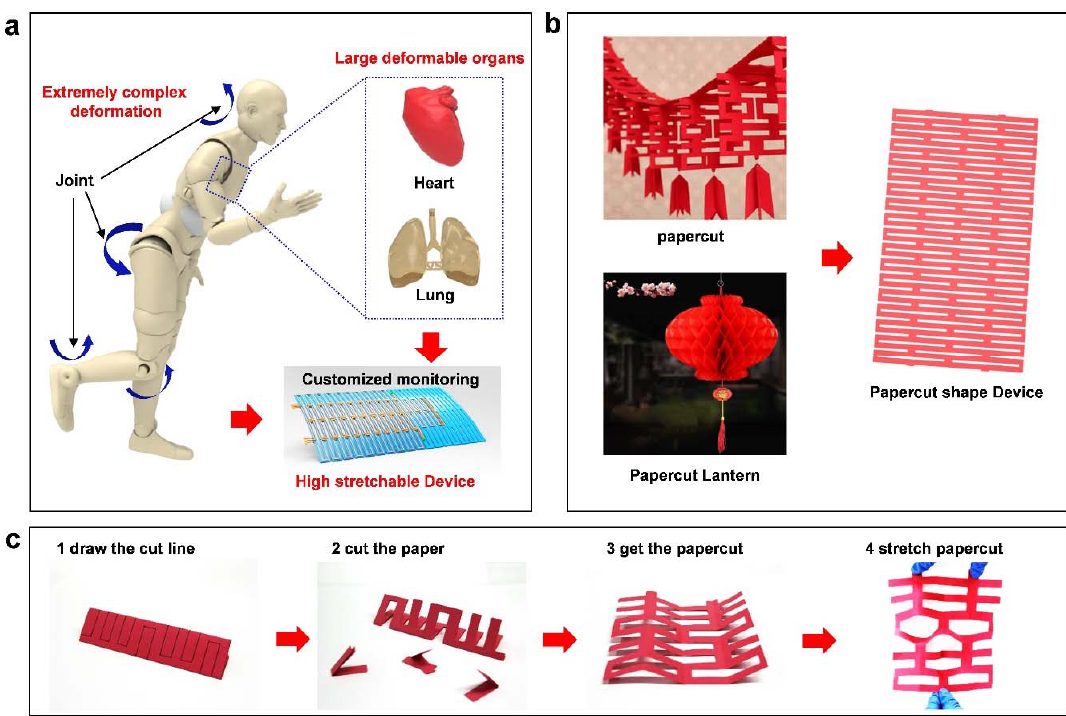
Figure 1. The design inspiration and concept of paper ‐ cut electronics: ( a ) The application scenarios of kirigami structure devices, including highly deformed organs and complex deformed joints. ( b ) The design of paper ‐ cut structure, inspired by traditional Chinese paper ‐ cut art and paper ‐ cut lanterns. ( c ) The process of cutting the paper ‐ cut structure.